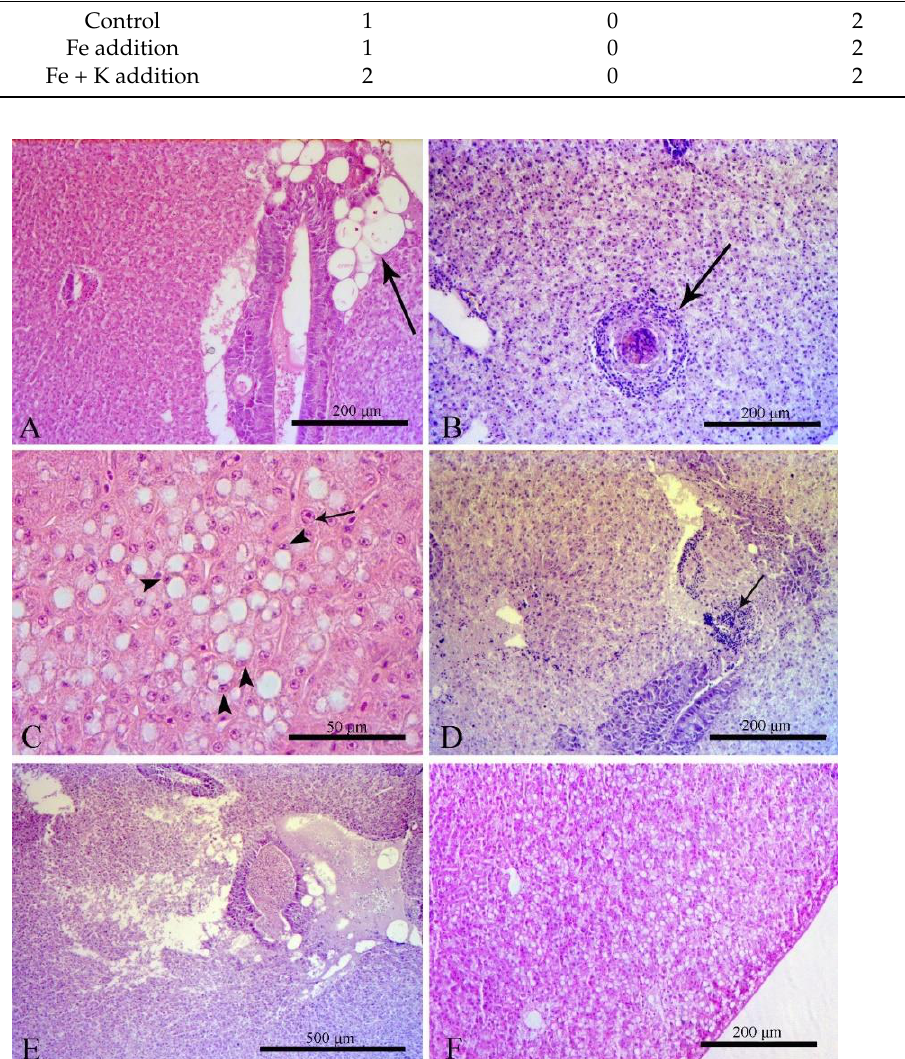
Figure 3. Histopathological examination of the liver. ( A ) Control group. Pancreatic islet macrosteatosis (arrow). ( B ) Fe group. Granuloma (arrow). ( C ) Fe group. Lipid droplets pressed some of the nuclei to the periphery of the hepatocytes (arrowhead). Some other nuclei appeared enlarged (arrow). ( D ) Fe group. One fish from this group showed focal inflammation signs (arrow). ( E ) Fe + K group. Necrotic region. ( F ) Fe + K group. Larger lipid accumulation.